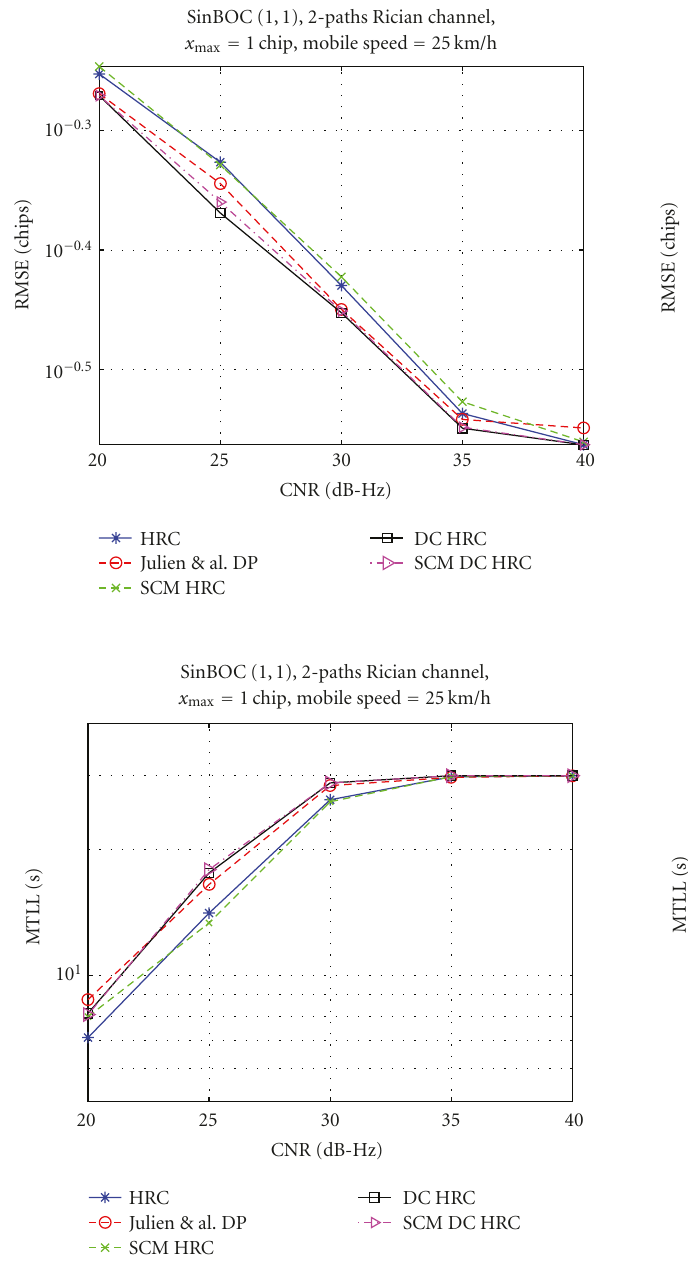
Figure 20: Comparison of feedback delays estimation algorithms employing the HRC discriminator and of the Julien&al. method, as a function of CNR; SinBOC(1,1) modulation, 2-paths Rician chan- nel with decaying PDP of 0 and − 2dB, v = 25km/h, maximum separation between paths x max = 1 chip.